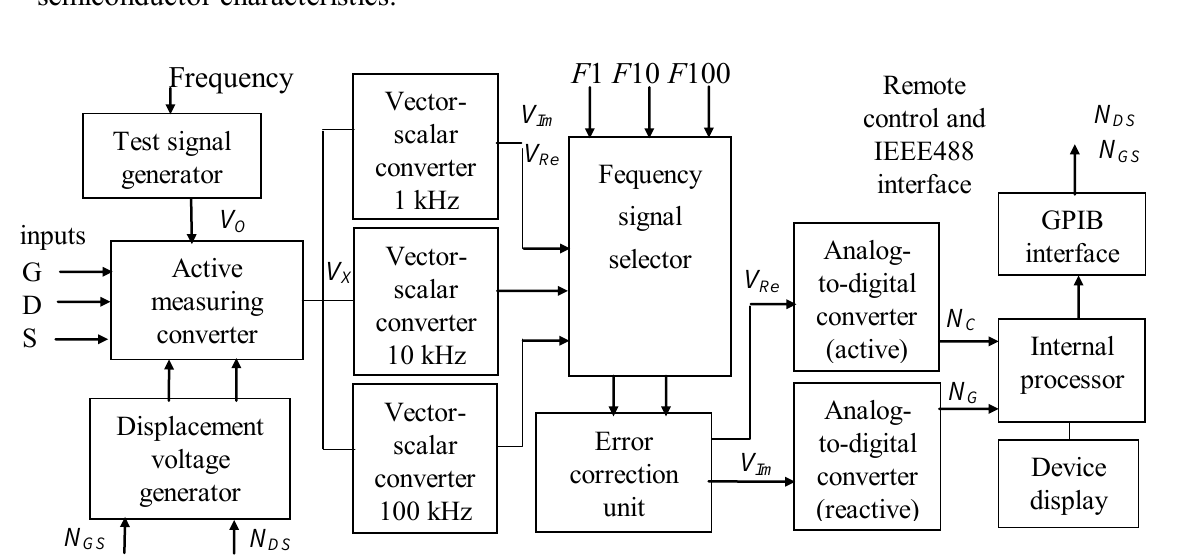
Figure 5. Block diagram of the measurement system for automatic control of semiconductor